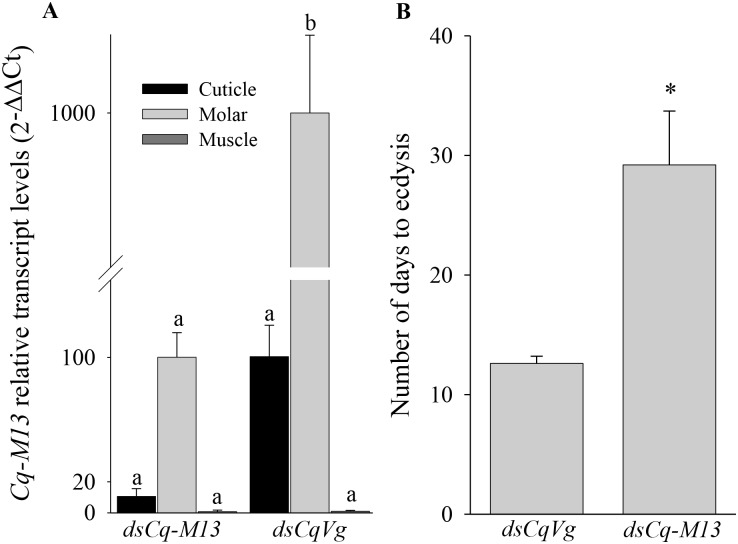

Cq-M13 silencing effects.
A. Levels of Cq-M13 transcripts following in vivo dsRNA injections in male crayfish, as assessed by real-time RT-PCR following short-term silencing. Animals were injected with ecdysone and either dsCq-M13 or dsCqVg. Different letters represent significant differences and error bars represent standard error (p < 0.05 ± SE). B. Molt cycle progress elongation of Cq-M13-silenced C. quadricarinatus males. The experimental group was injected with Cq-M13 dsRNA and the control group was injected with CqVg dsRNA. Both groups were injected with ecdysone to induce their molt cycle. Asterisk represents a significant difference (p < 0.05± SE).